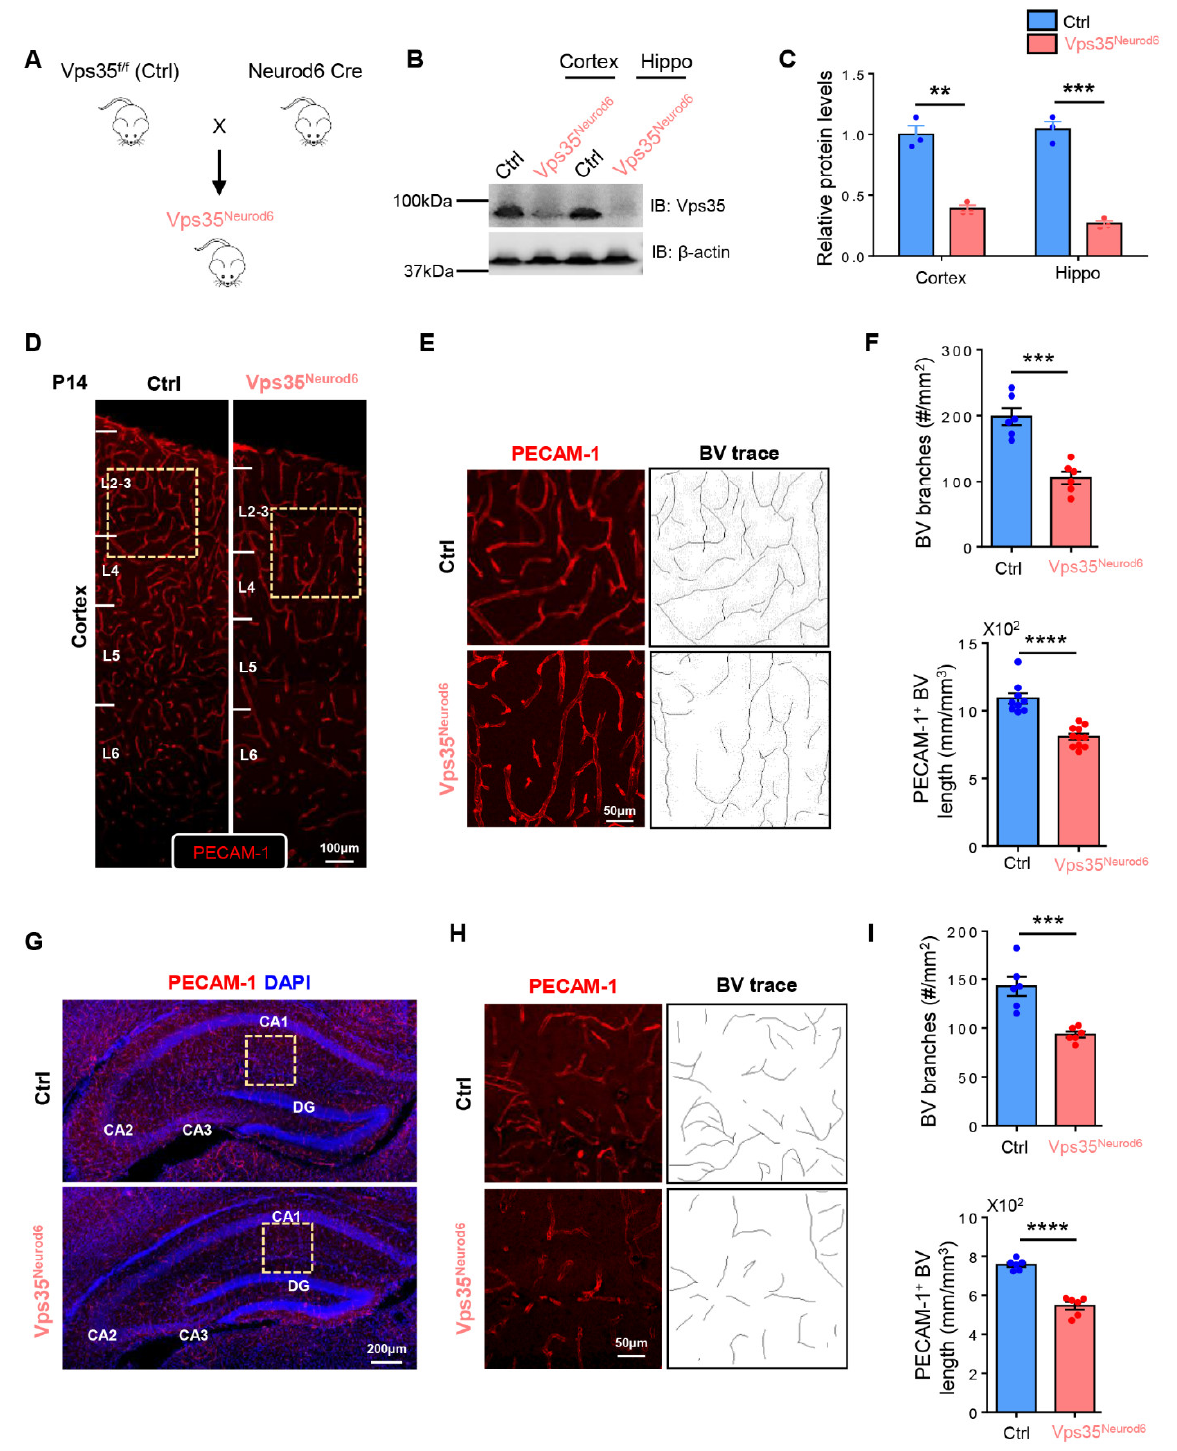
Figure 1. Reduced PECAM-1 + vessels in Vps35 Neurod6 cortex and hippocampus. ( A ) Vps35 f/f mice were crossed with Neurod6 Cre mice to generate Vps35 Neurod6 mutant mice. ( B ) Western blot analysis of Vps35 level in the cortex and hippocampus taken from Vps35 f/f and Vps35 Neurod6 animals. β-actin was employed as a loading control. ( C ) Quantification analysis of relative Vps35 protein expression level from B (n = 3 animals per genotype; two-tailed unpaired t test). ( D ) Representative images of blood vessels (BVs) in the cortex of control and Vps35 Neurod6 mice at age of P14. Brain sections were subjected to immunostaining analysis using PECAM-1 antibodies (red). ( E ) Higher-magnification images of the boxed regions of D and BV. ( F ) Quantification of PECAM-1 + vessel length and BV branches in E (n = 3 mice per genotype; two-tailed unpaired t test). ( G ) Representative images of